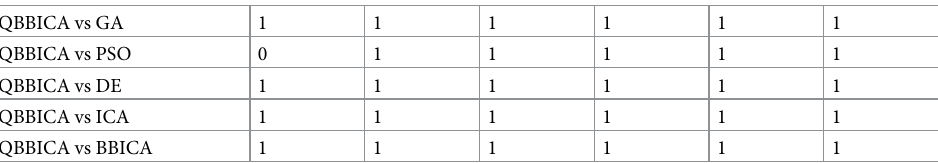
Table 3. h -value of Wilcoxon test